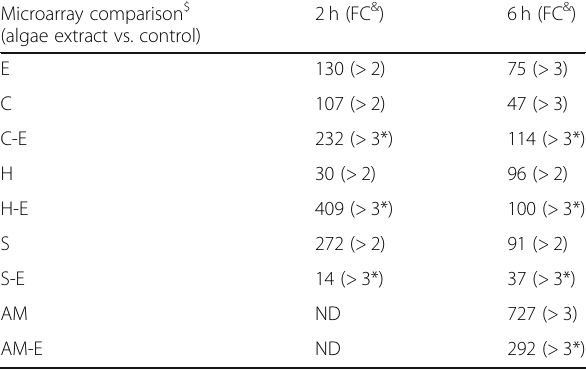
Table 2 Number of DEGs selected from each comparison of treated IPECJ2 cells versus control cells and used for functional